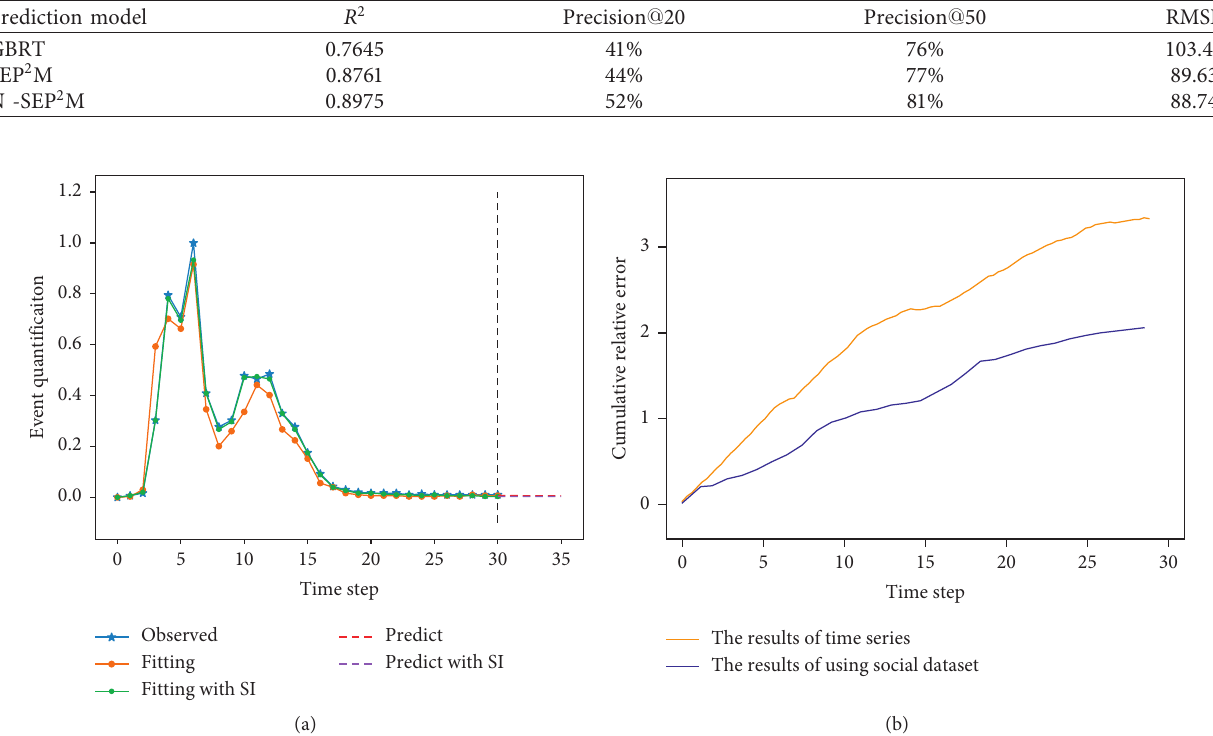
Table 3: Comparison of the evaluation indicators of prediction models.